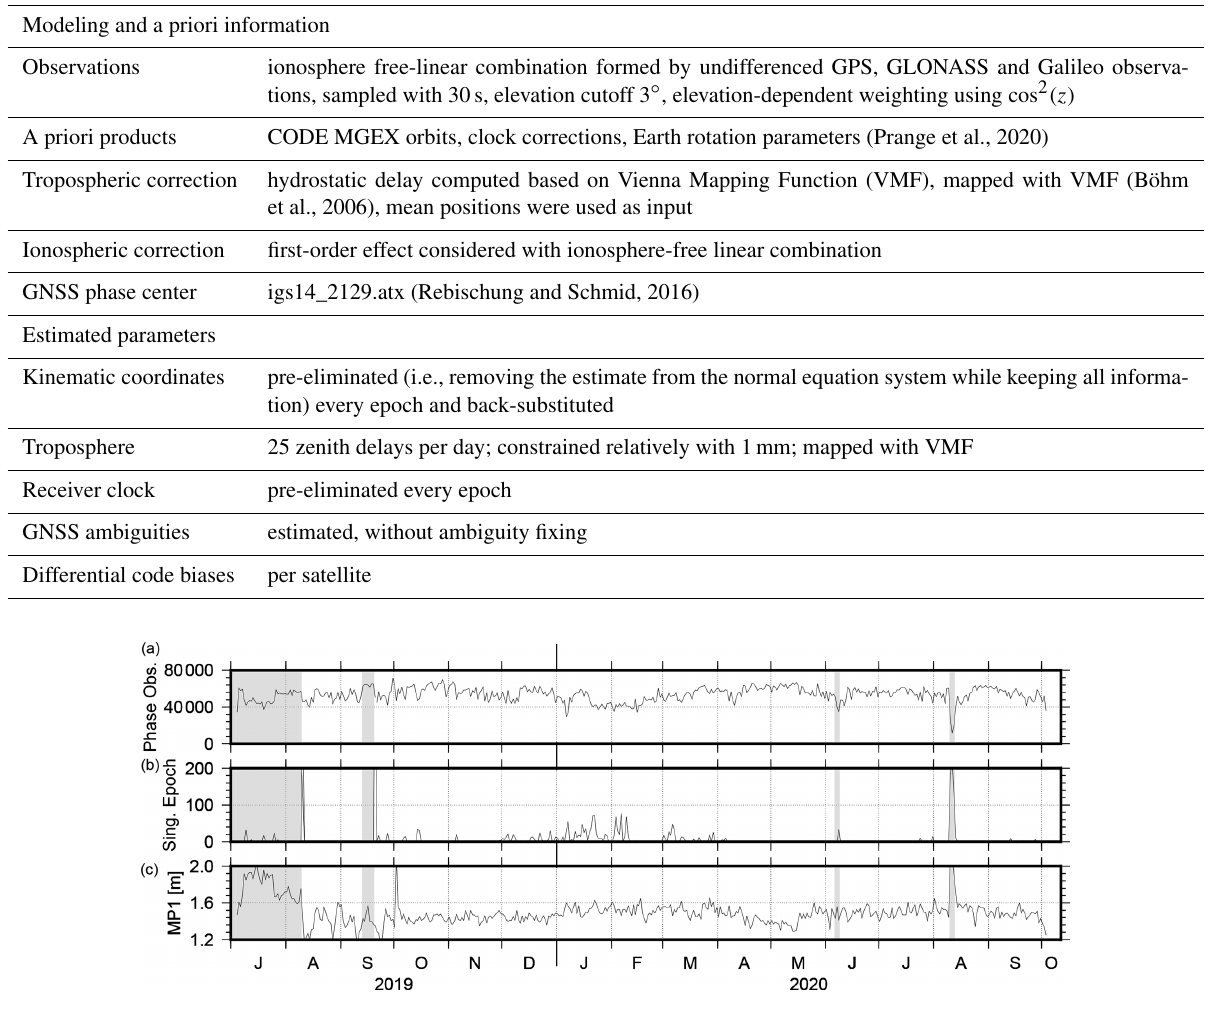
Table 1. Summary of estimation and processing strategy.